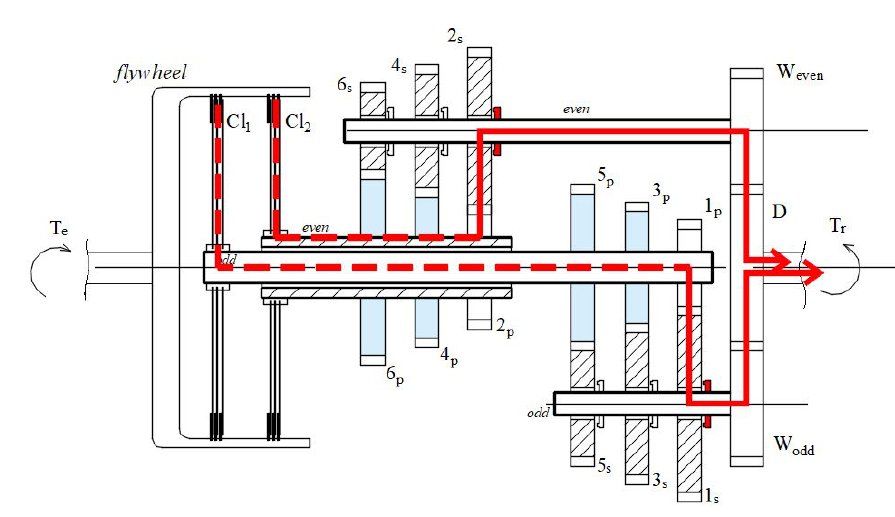
Figure 6. The DCT gear shifting transient: the Cl 1 and Cl 2 clutches crossing phase.